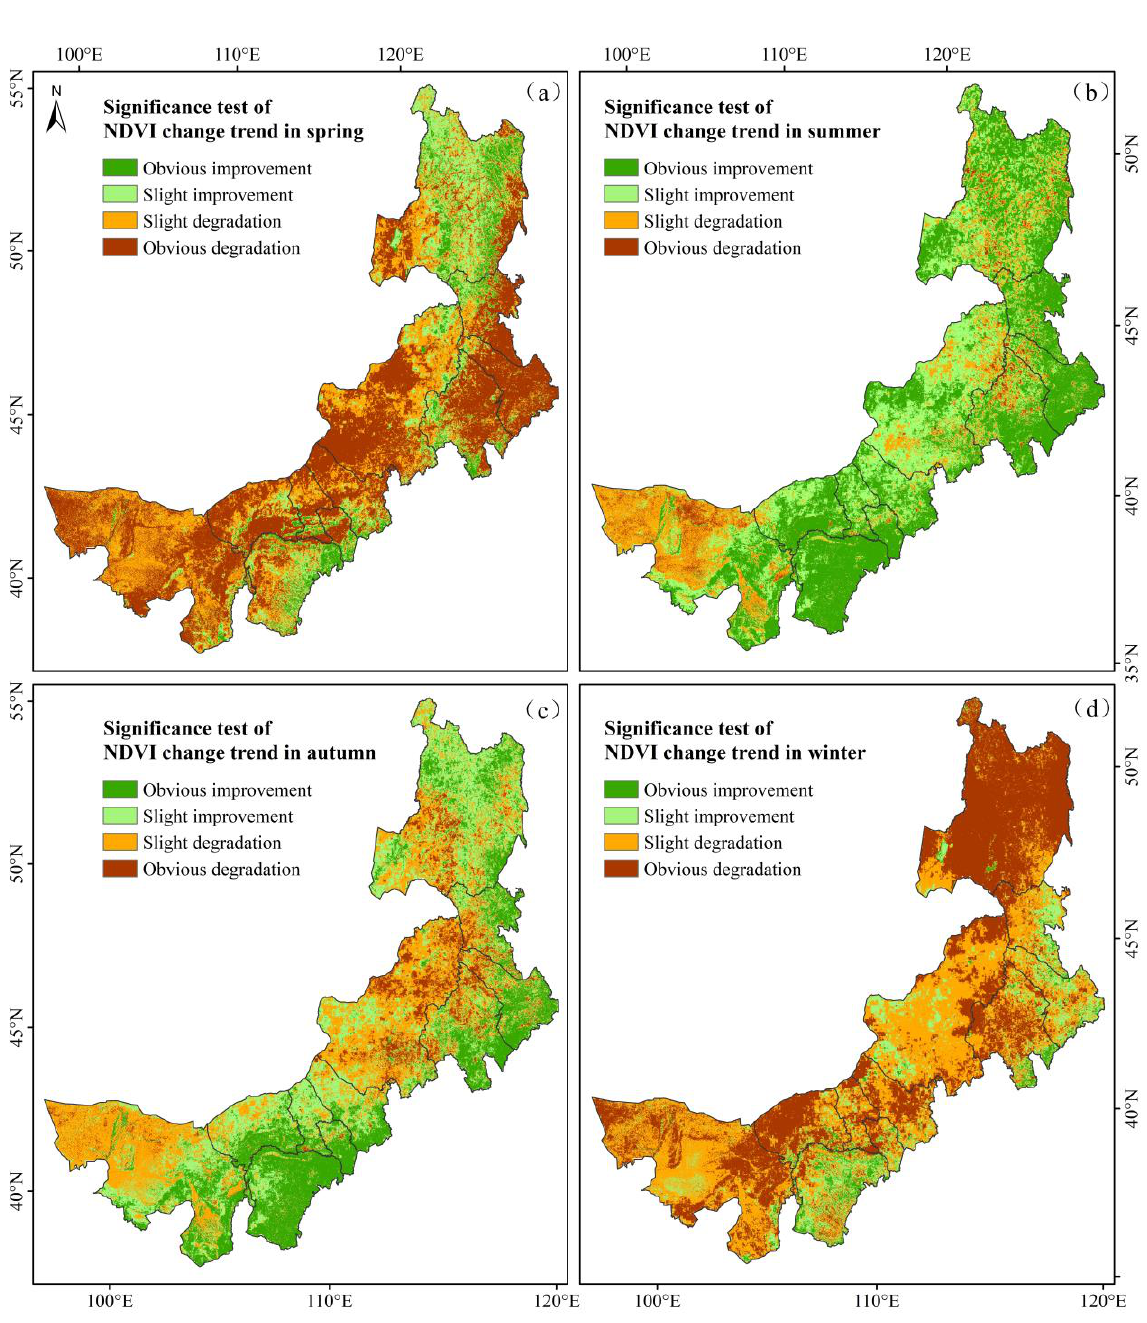
Figure 8. Significance tests of NDVI spatial change trend in four seasons in Inner Mongolia. ( a – d ) represent spring, summer, autumn, and winter, respectively. Table 4. Classification and area proportion statistics of the NDVI change trends in four seasons.